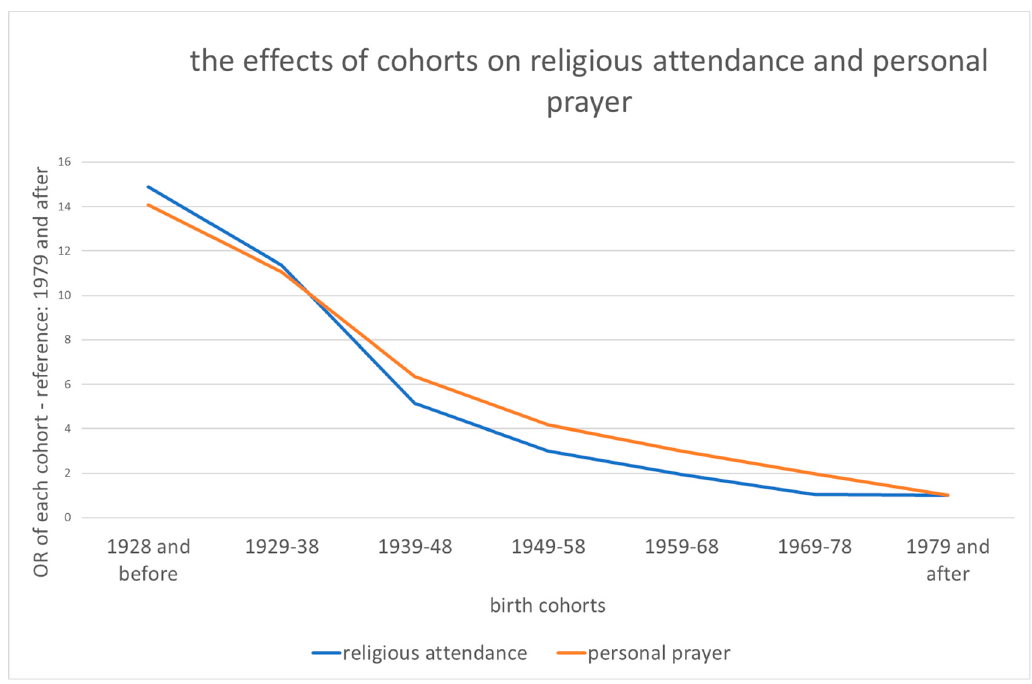
Figure 6. The effects of cohorts on religious attendance and personal prayer—odds ratios.